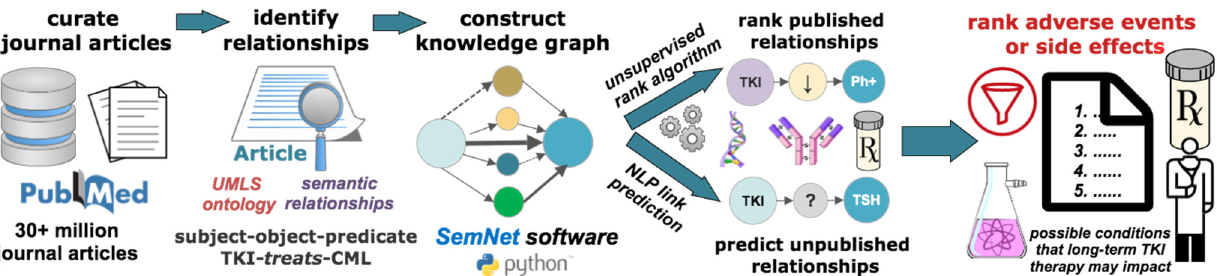
Figure 1. Overview of cross-domain text mining relationships extracted from peer-reviewed articles in PubMed and connected into a knowledge graph. Subject-object-predicate triples are extracted from the text of journal articles, which relate two or more nodes or “concepts” of interest. The knowledge graph ontology is specified by the Unified Medical Language System (UMLS). Example